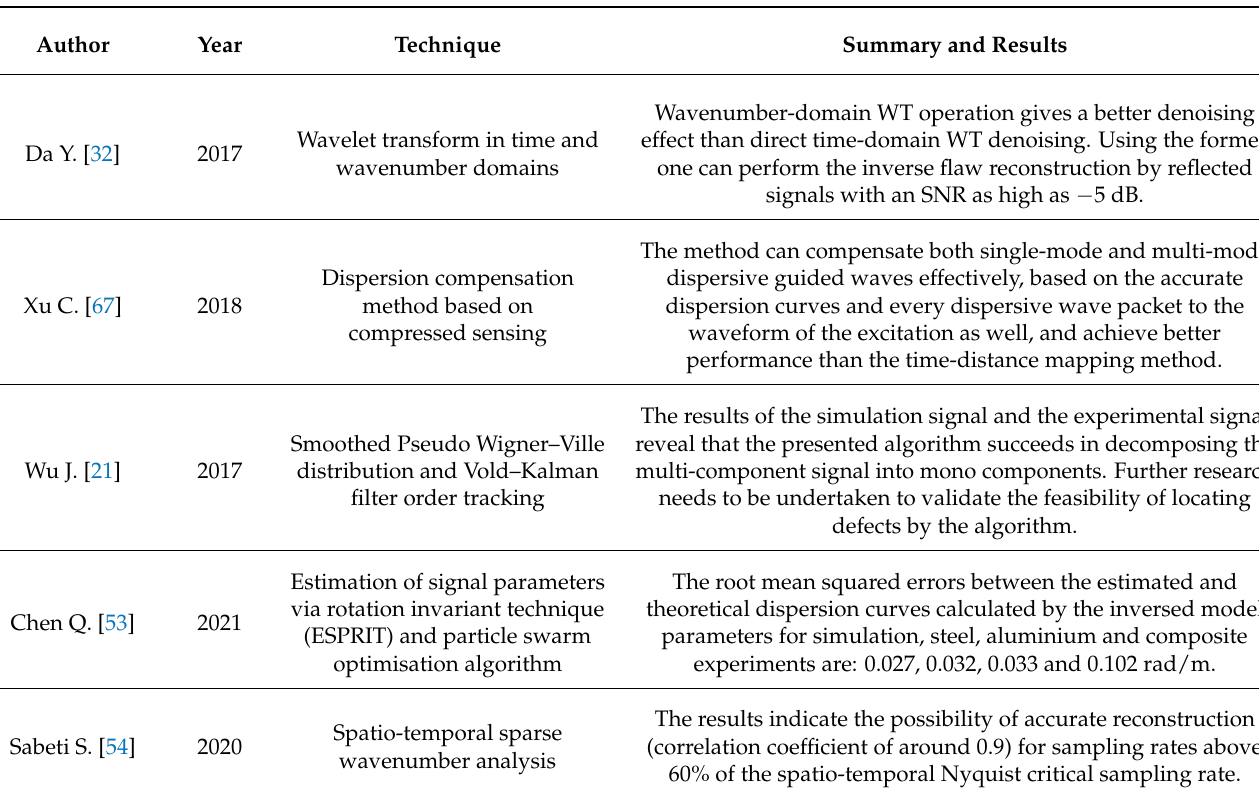
Table 3. Works found addressing signal processing techniques applied to